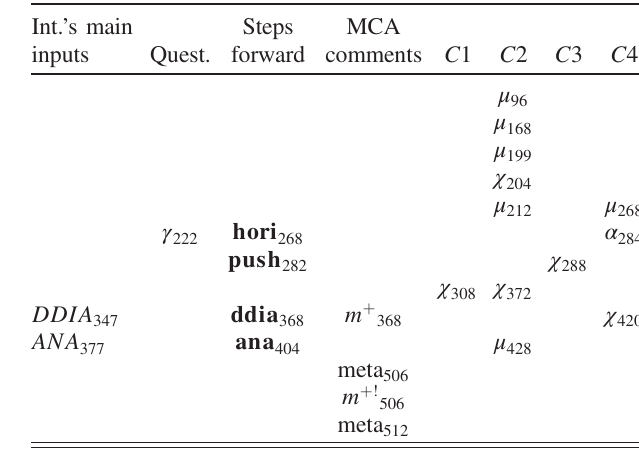
TABLE VI. Mapping F ’ s intellectual pathway. In the case of F , there are fewer direct questions about meanings, with multiple attenuated critiques and to-and-fro in relation to C 2 and C 4 , although he was at ease with comprehension of the situation itself (hori, push, ana). There is great satisfaction at the end, particu- larly in relation to the dislocated diagram, even though the final formulation of his critique concerning C 2 remains mitigated ( μ